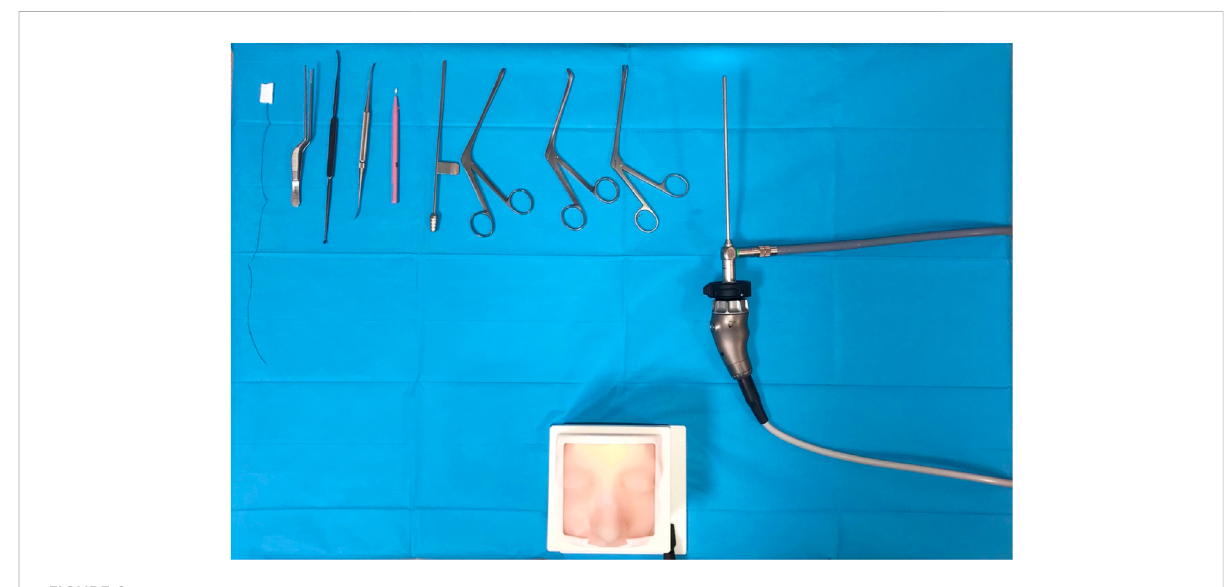
FIGURE 8 Simulation setting and instruments for non-destructive